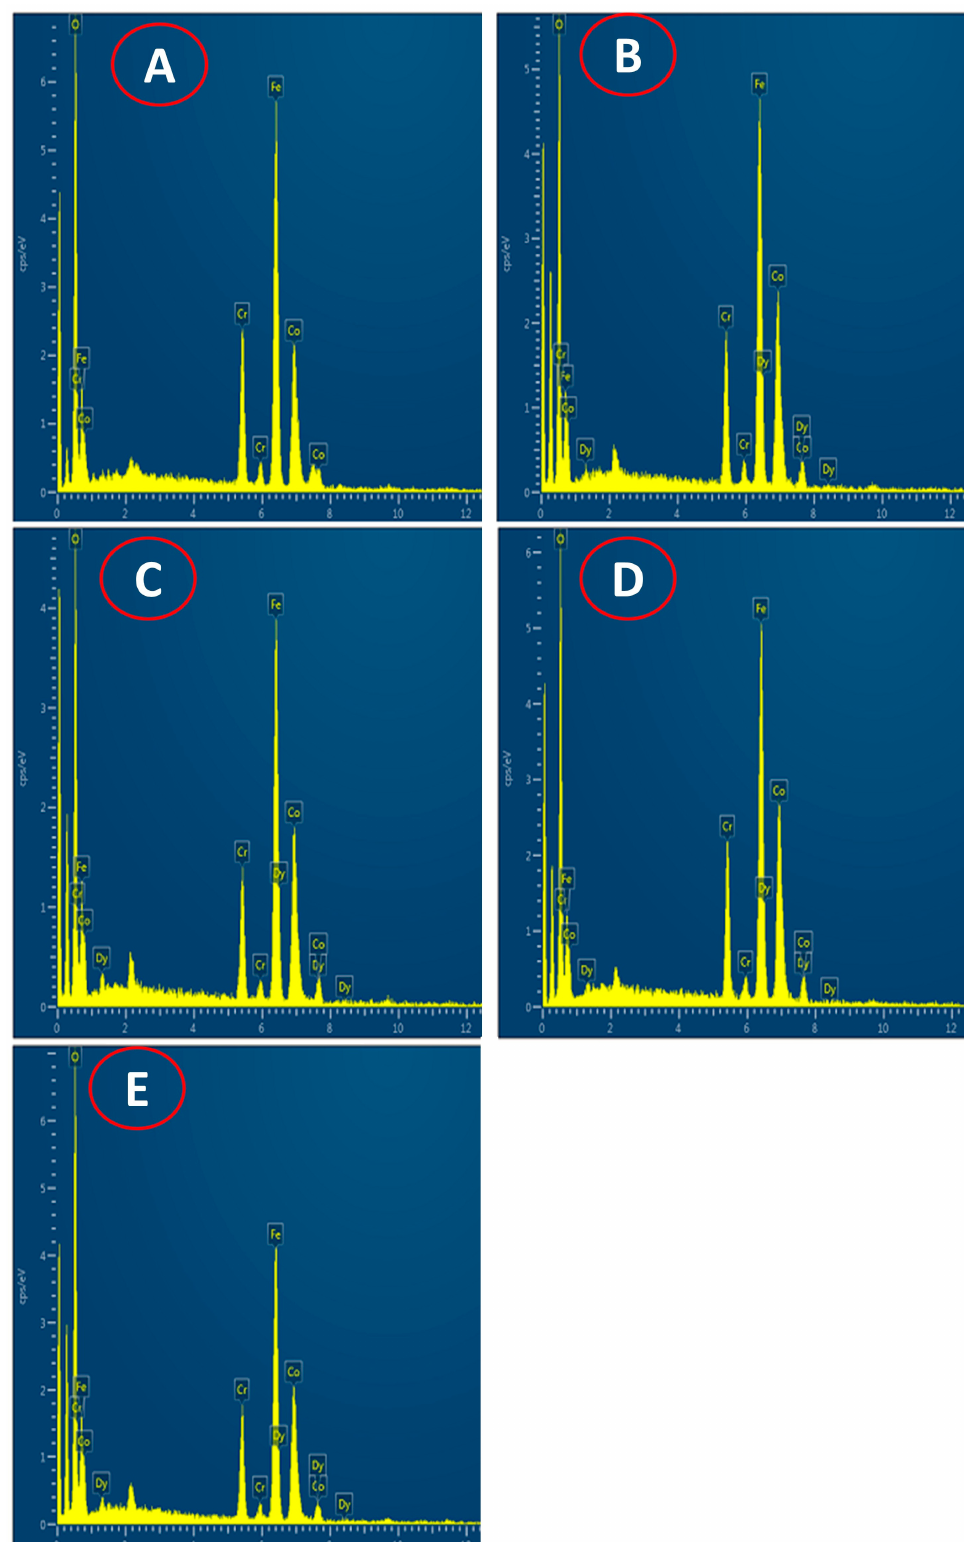
Figure 6. EDAX spectra of CoCr 0.5 Dy x Fe 1.5-x O 4 where ( A ) x = 0.0, ( B ) x = 0.025, ( C ) x = 0.050, ( D ) x = 0.075 and ( E ) x = 0.1.